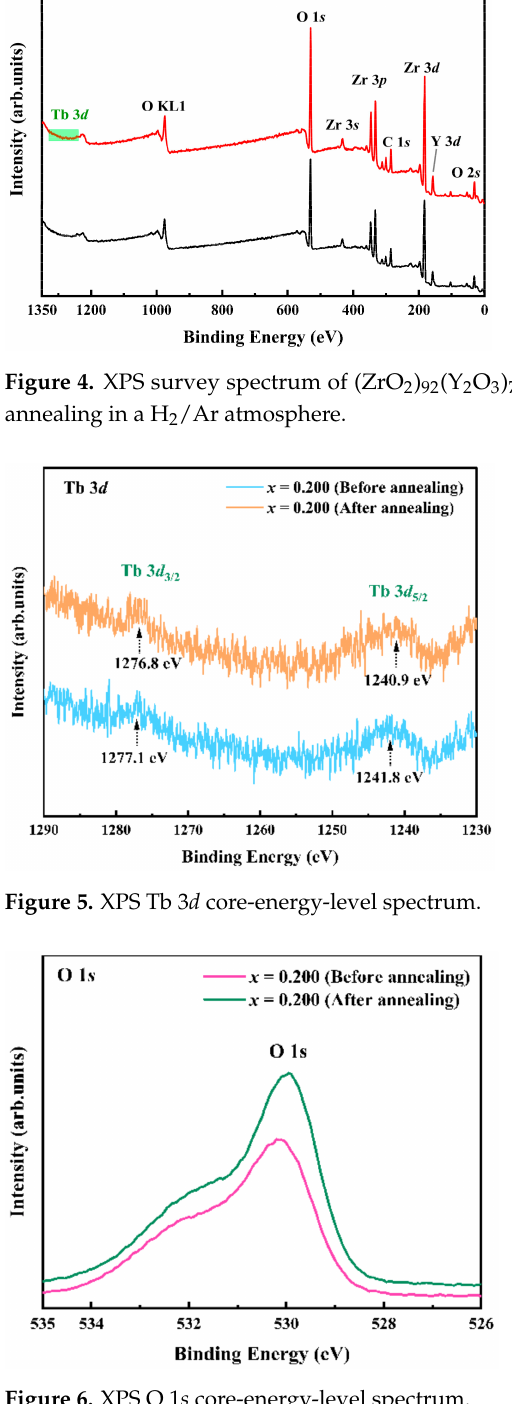
Figure 6. XPS O 1 s core-energy-level